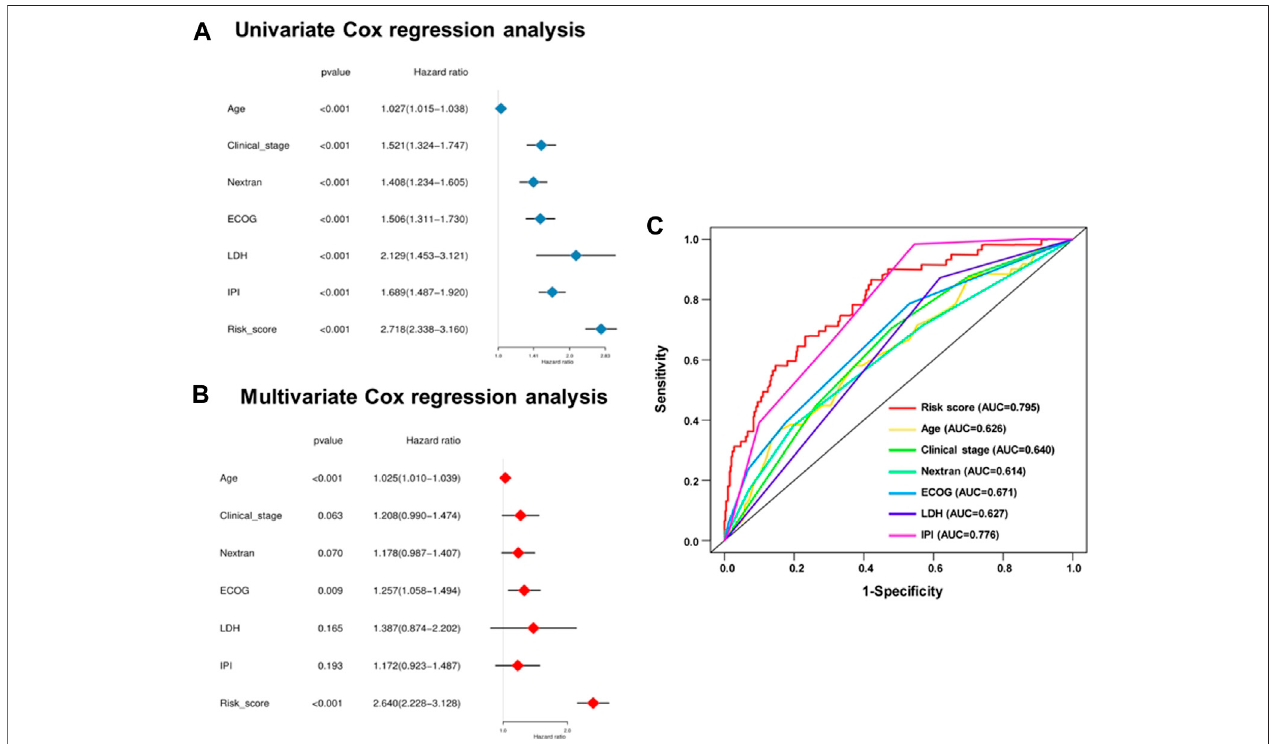
FIGURE4| Univariateandmultivariateanalysisshowstheprognosticvalueof11-SE-associated-genesignature.Univariate (A) andmultivariate (B) Coxregression analysesoftheassociationbetweenclinicopathologicalfactorsandOSofDLBCLpatients. (C) Thereceiveroperatorcharacteristic(ROC)curvestopredictthesensitivity and speci fi city of clinicopathological factors and 11-SE-associated-gene signature-derived risk scores in DLBCL patients.